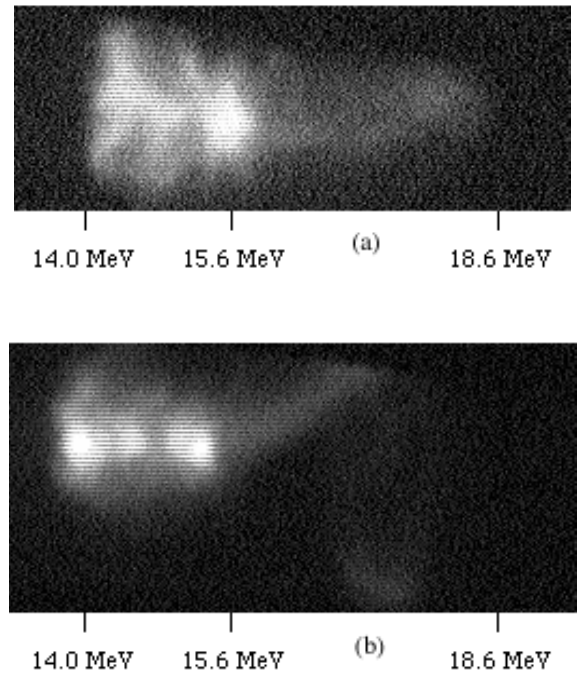
FIG. 8. Video image made by beam, with no plasma present, striking phosphor of focal plane in momentum analyzing spectrometer, for (a) typical narrow spectrum case and (b) larger momentum spectrum due to injection phase fluctua- tion. Note the transverse (vertical dimension) structure of the image in this case.